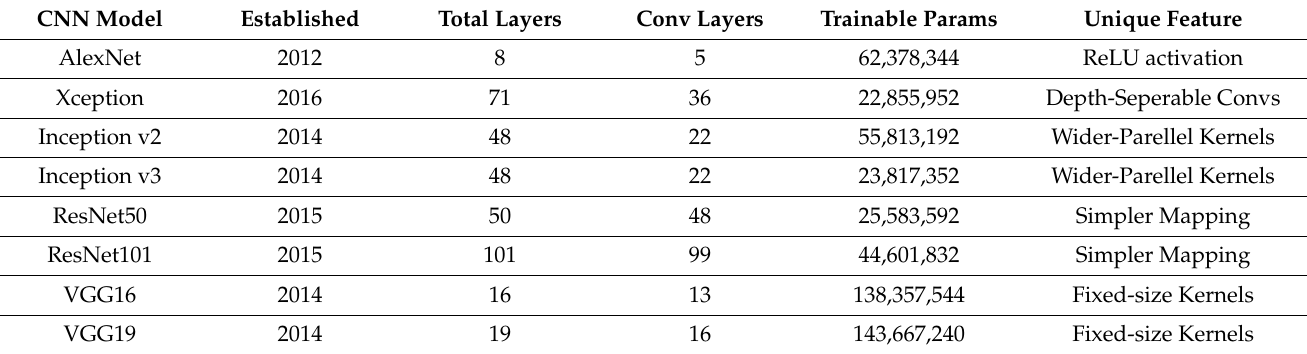
Table 1. Comparison of different CNN Models used in our